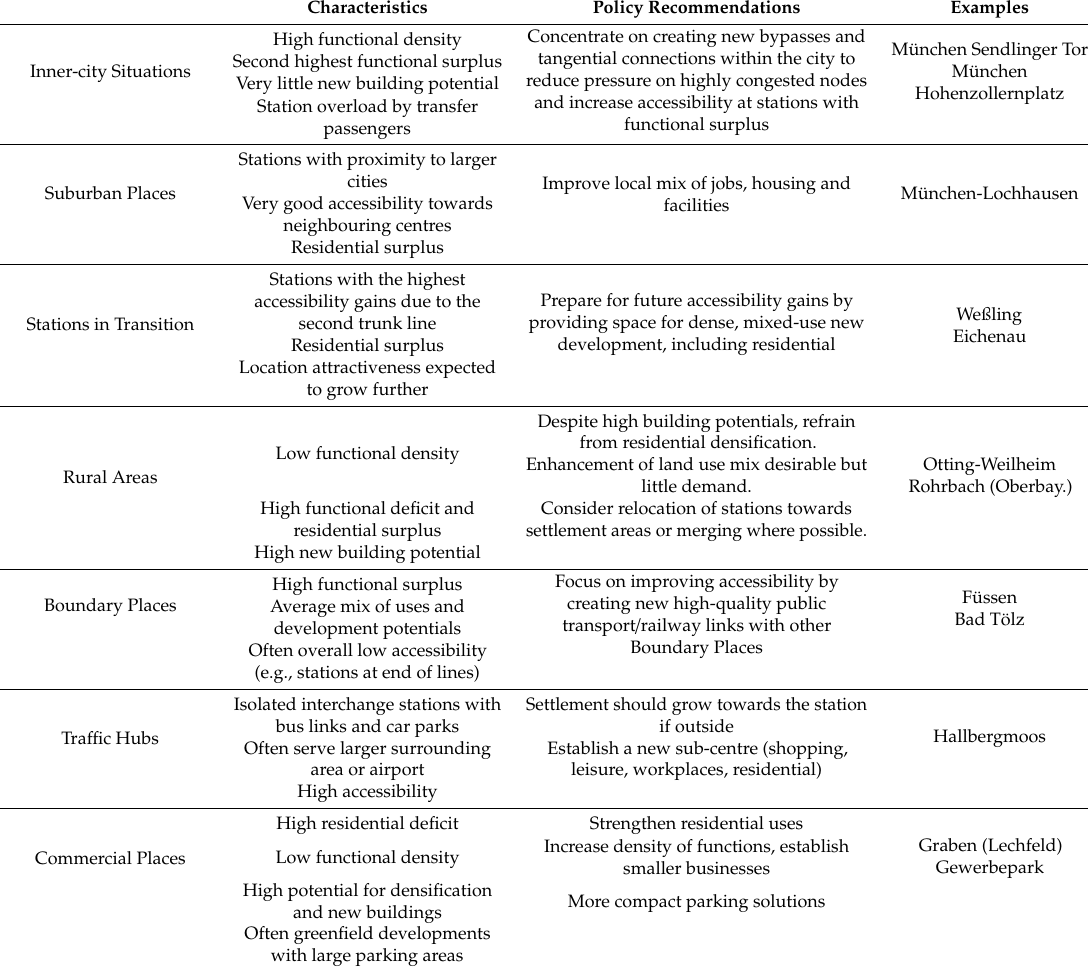
Table 3. Characteristics, policy recommendations and examples for the